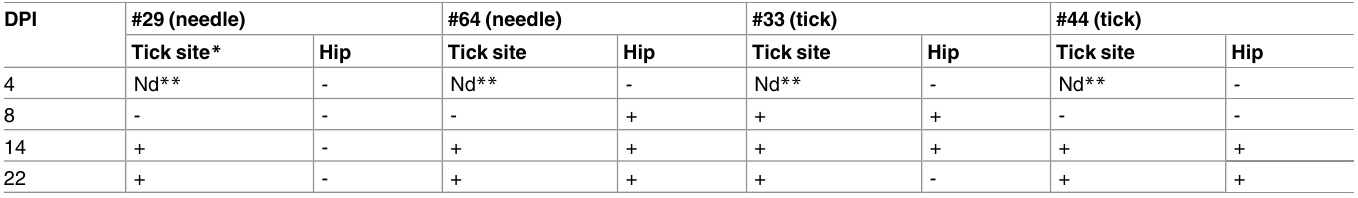
Table 1. Detection of Rickettsiaslovaca DNA in the skin of goats following inoculation via needle or tick bite.